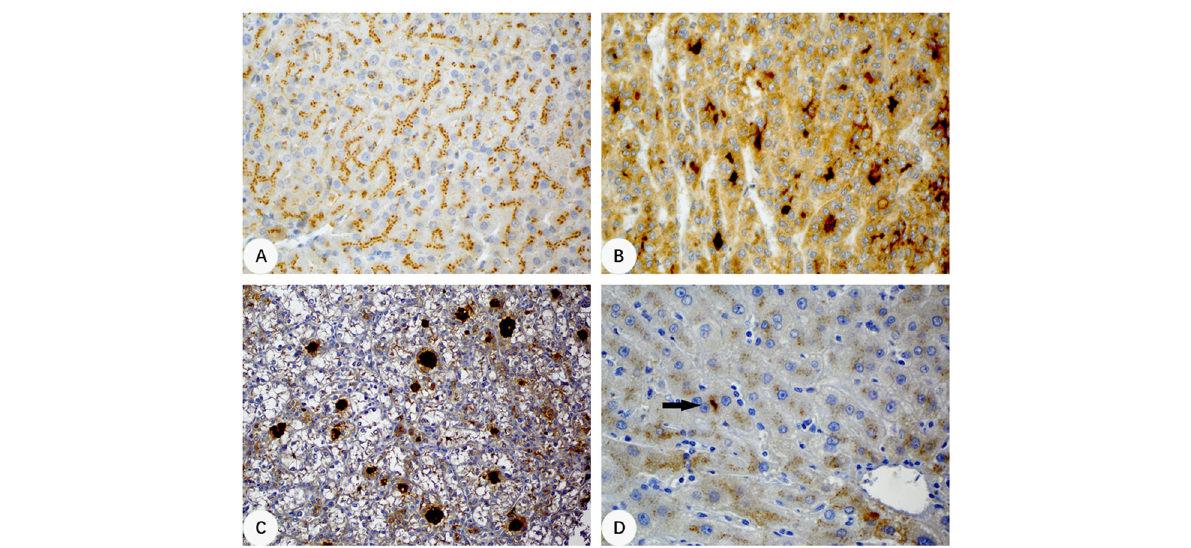
Fig. 1 Immunohistochemical staining patterns of CLU in normal liver, RNs and HCC. a , Normal liver tissue showing a delicate, fine granular and “ railroad track ” -like pericanalicular pattern (400x). b , A HCC showing a unique enhanced canalicular staining pattern (400x). c , A HCC with pseudoglandular structures showing intraluminal staining pattern (200x). D, A RN showing focal enhanced canalicular staining pattern involving one canaliculus (arrow,